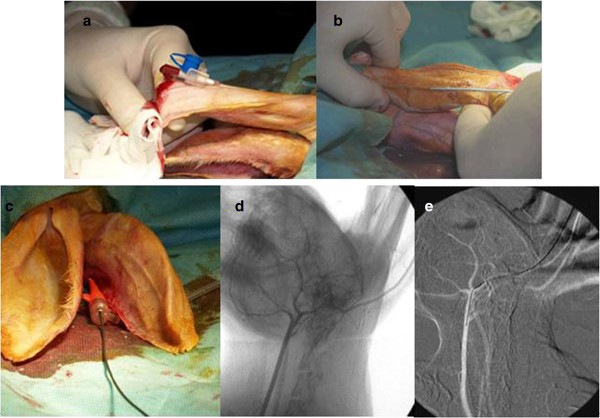
Intraarterial transauricular access in the rabbit thoracic aorta. a. Direct percutaneous catheterization of the central auricular artery with a 22-gauge intravenous catheter, b. Repeated tract dilations of the peripheral transauricular artery with the introduction of a 4-F vascular sheath, c. Insertion of an 6.0-mm/40- mm (Cordis) peripheral dilatation balloon catheter over the guide wire, d-e Roadmap image of the auricular artery and the common carotid artery.